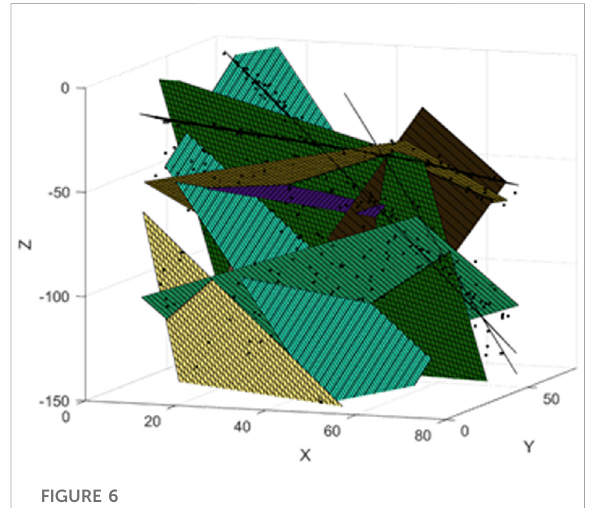
FIGURE 6 Result of fracture modeling without orientation data. The extracted planes were overestimated compared to the true model shown in Figure 3A.